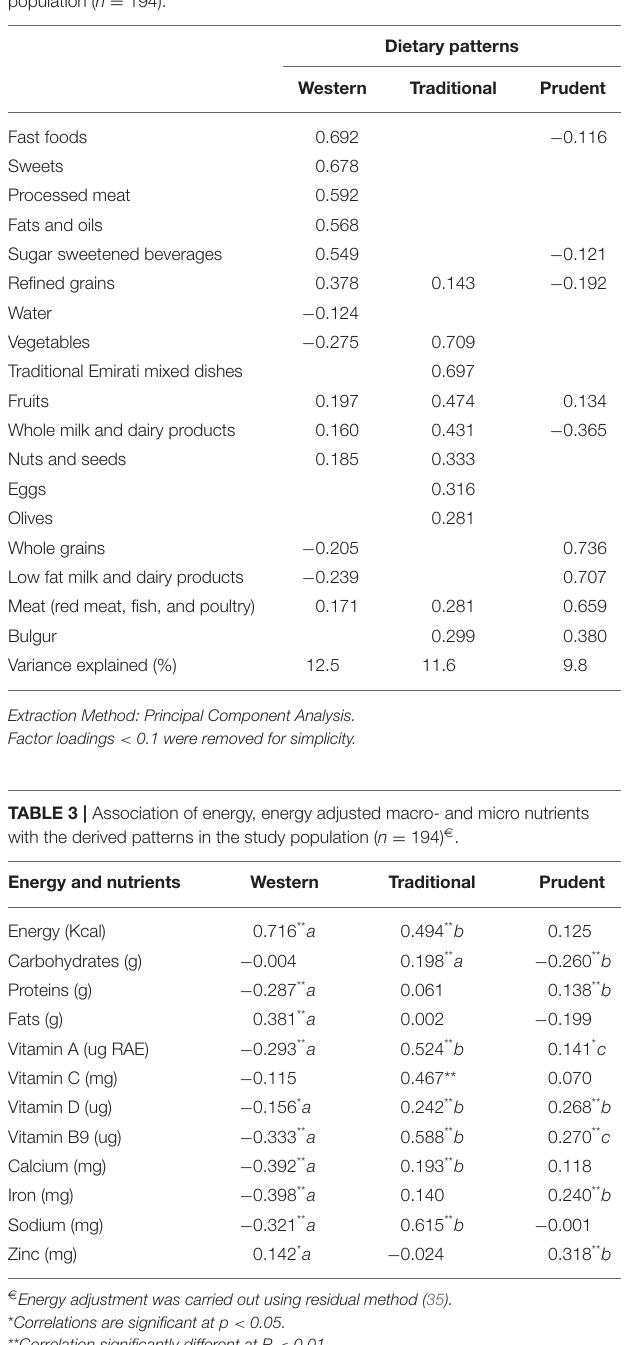
TABLE 2 | Factor loadings of the various food groups and their corresponding patterns, as derived from Principal Component Analysis (PCA) in the study population ( n = 194).